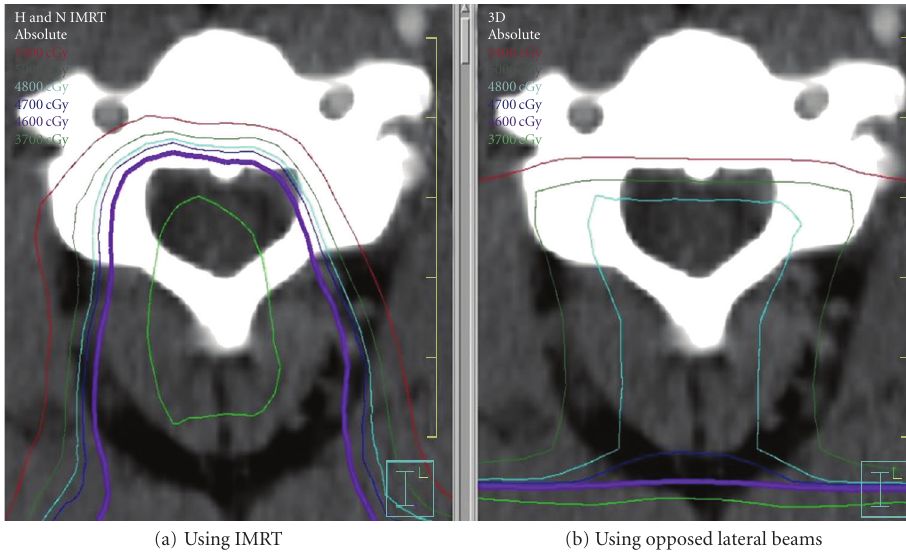
Figure 2: Radiation dose distribution represented by radiation isodose lines through an axial plane of the cervical spinal cord. (a) Dose distribution with IMRT and (b) dose distribution using a non-IMRT plan using opposed lateral beams. The light blue line represents the 4800 cGy isodose line and the purple line represents the 4500 cGy isodose